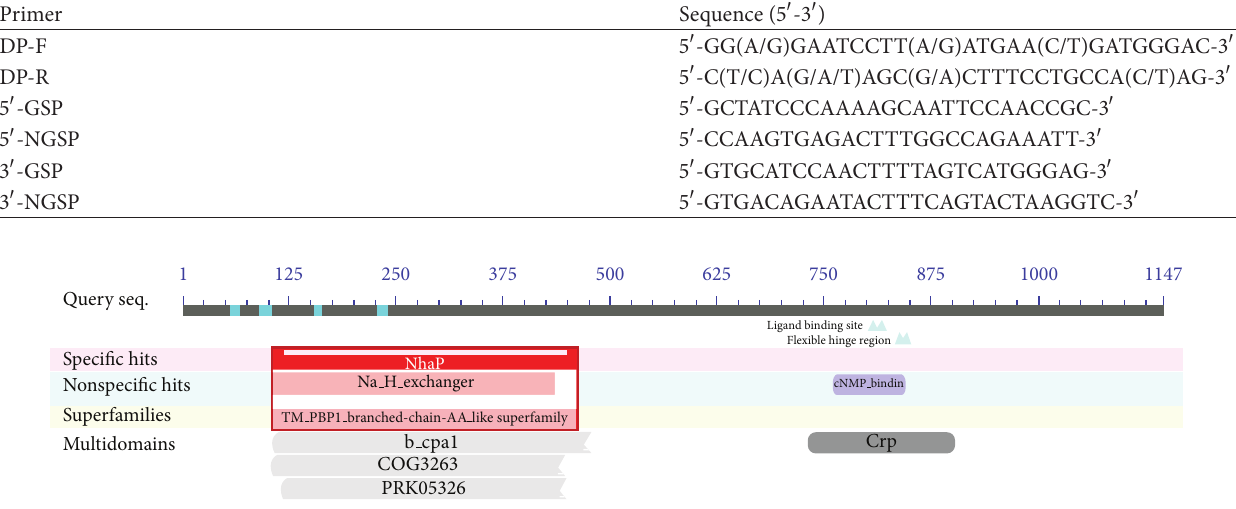
Figure 1: Analysis of conserved domains in KvSOS1.